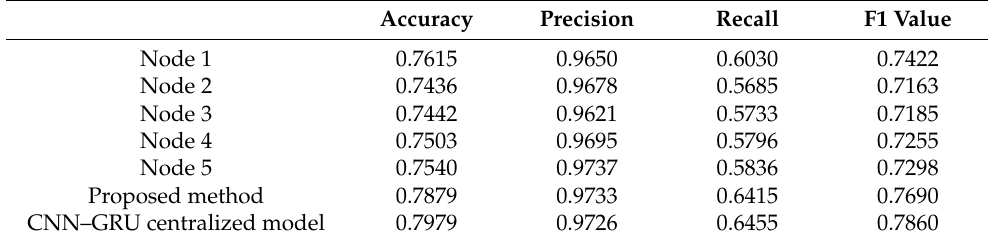
Table 4. FL intrusion detection effect.